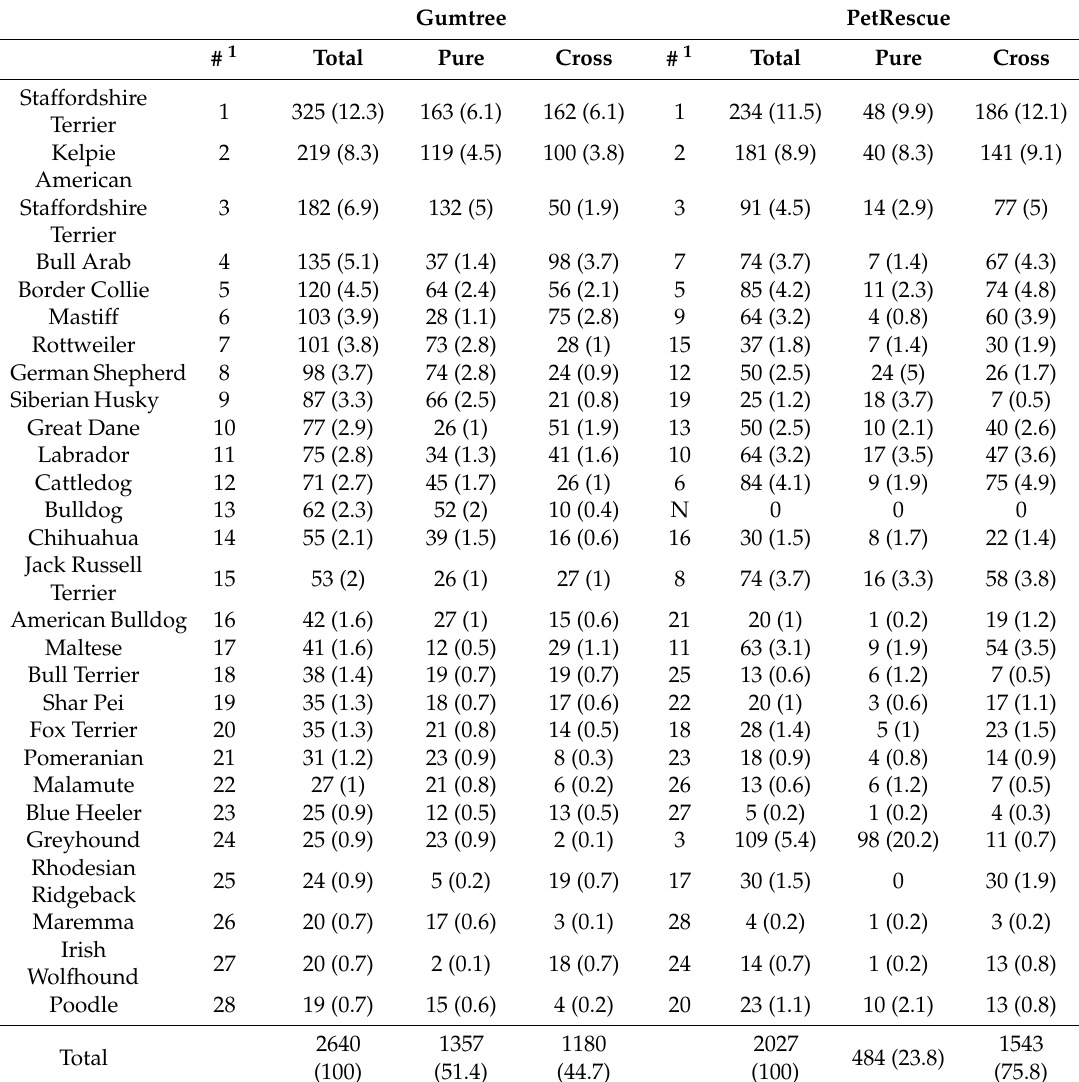
Table 1. Dog breeds in which 20 or more individuals were relinquished on Gumtree or Pet Rescue from 8 February to 24 February 2016 (In 103 dogs the purebred status was